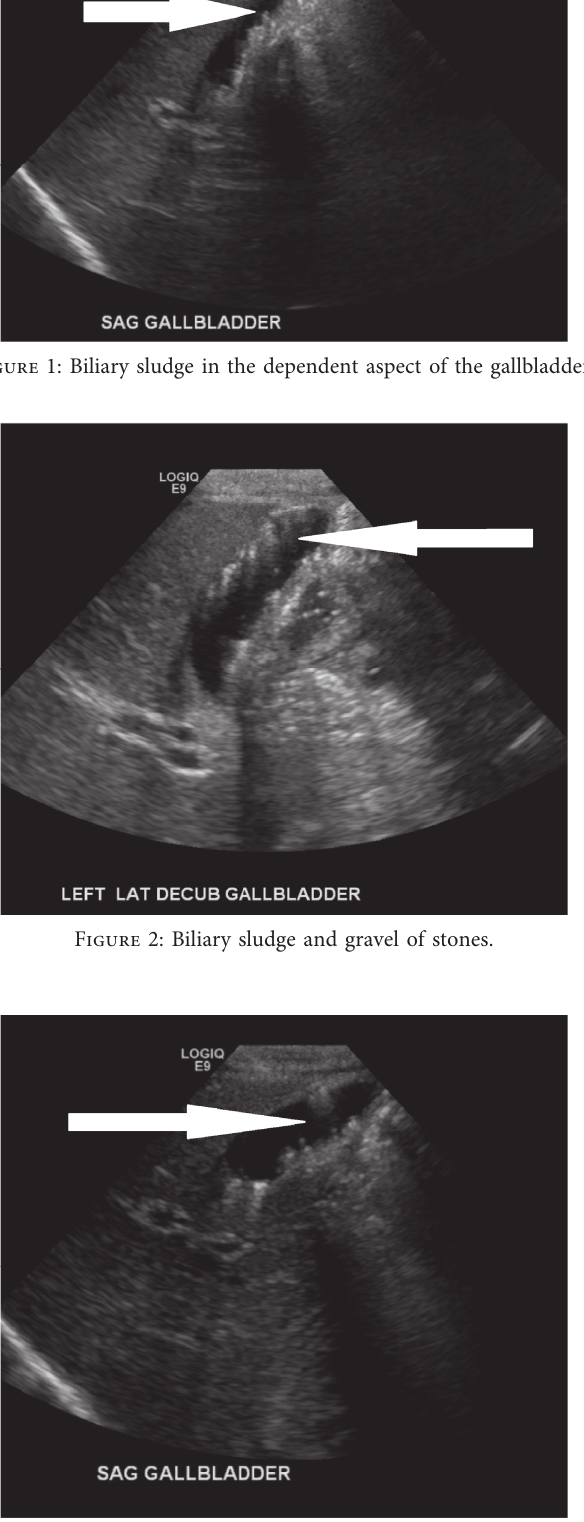
Figure 3: Multiple